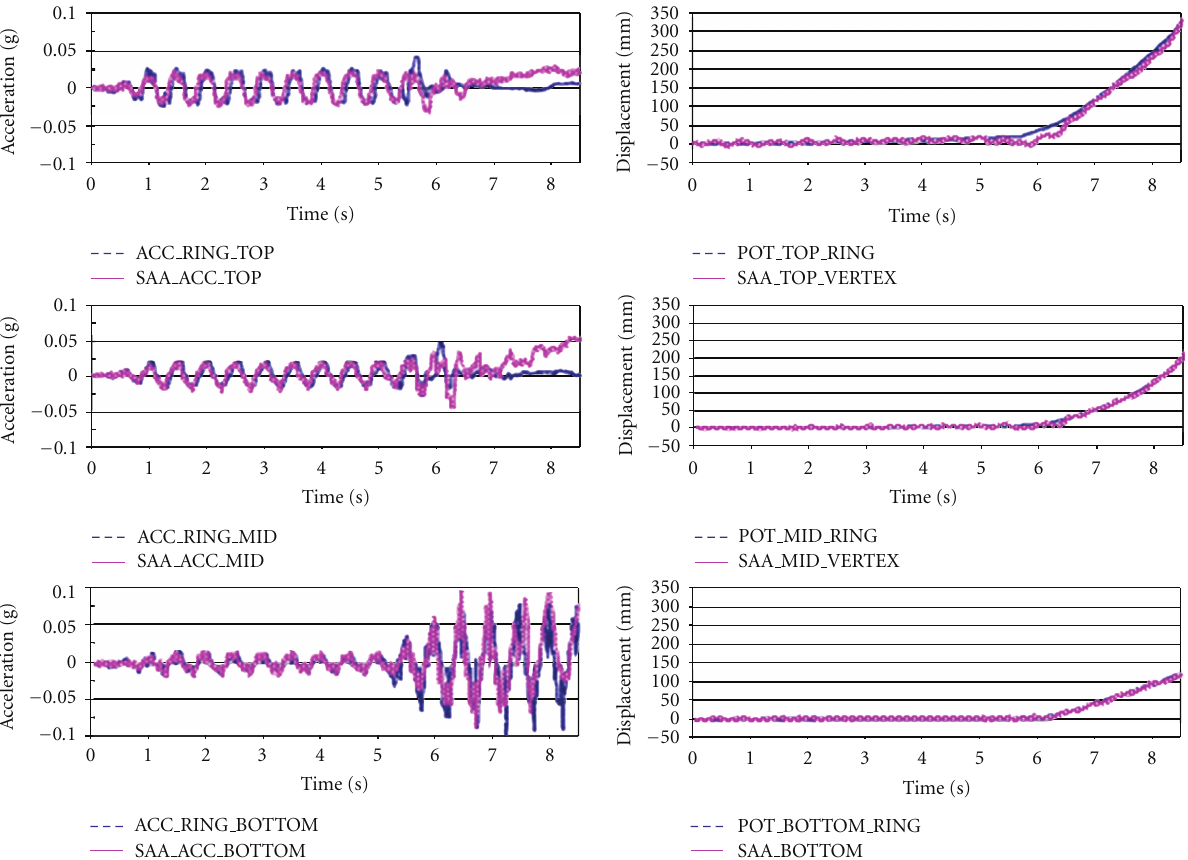
Figure 3: Acceleration (g) and lateral displacement comparison (mm) between SAA and laminar ring accelerometers and potentiometers, respectively, at the soil surface (0 m depth), mid-depth (2.8m depth), and bottom of soil deposit (5.6m depth); ACC RING = Accelerometer on Laminar Ring, POT = potentiometer on laminar ring, SAA = shape acceleration array.